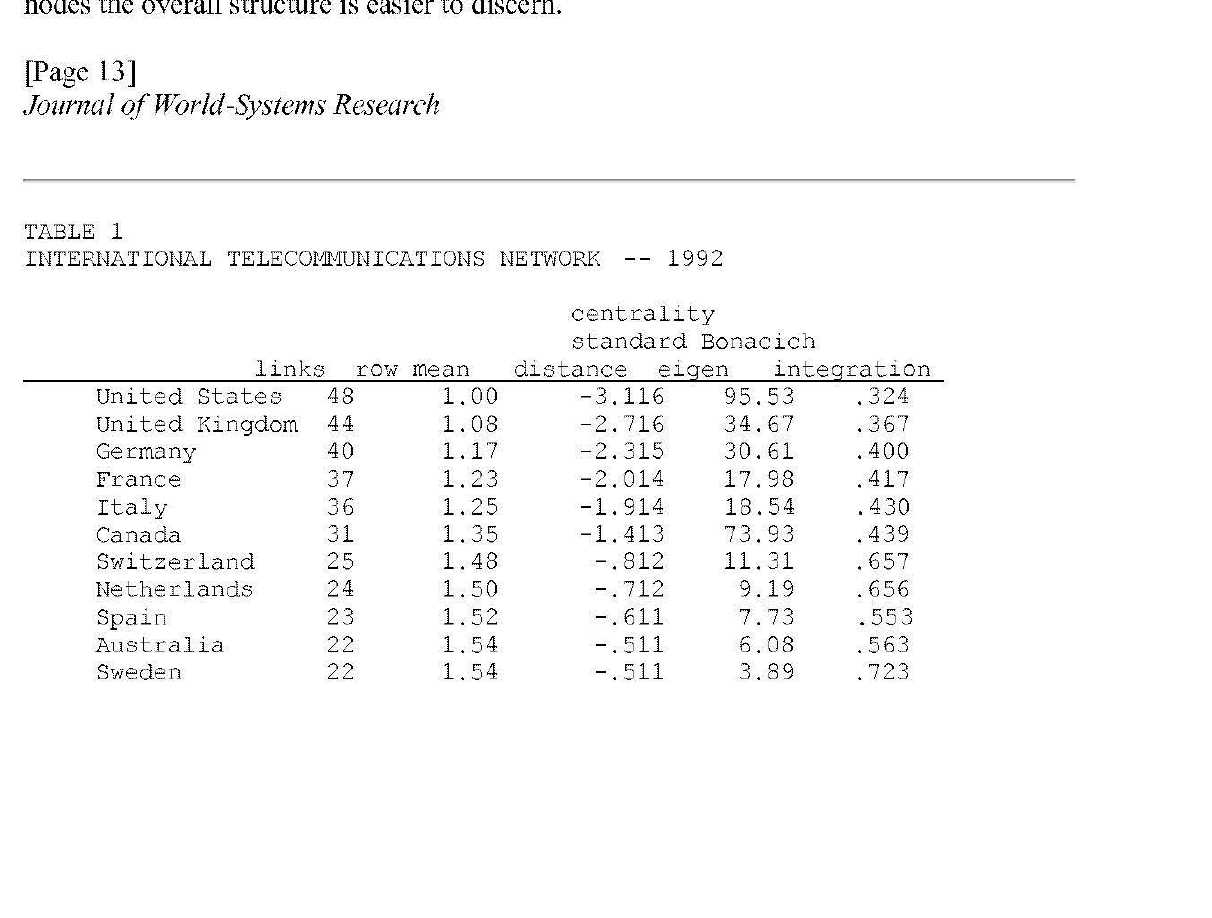
INTERNATIONAL TELECOMMUNICATIONS NETWORK